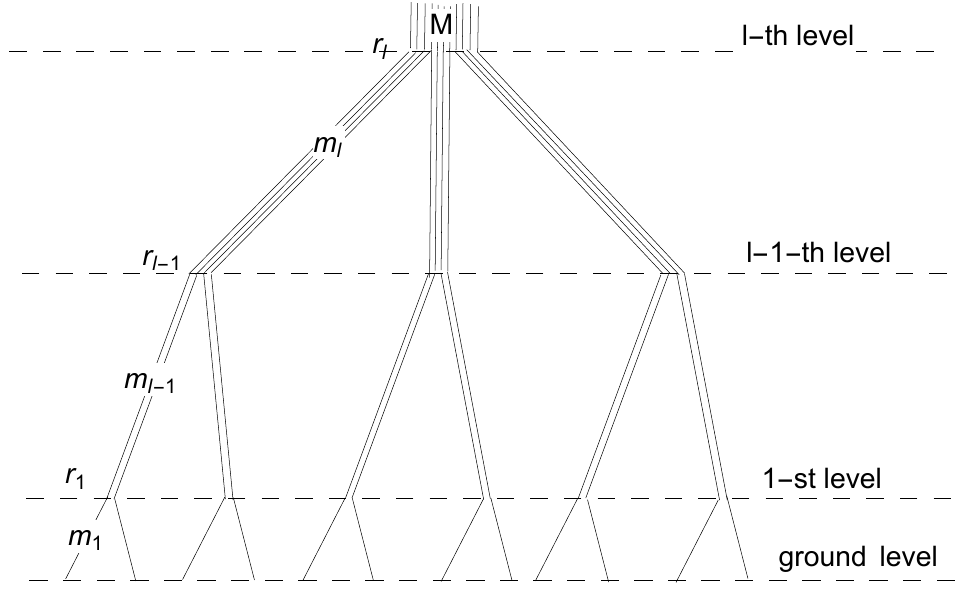
Figure 11 . Illustration of the tree structure of a Parisi matrix with given rami(cid:12)cations f r g . The dimensions f m g are represented by thickness of 1 ; r 2 ; r 3 : : : r l 1 ; m 2 ; r 3 : : : m l ; M